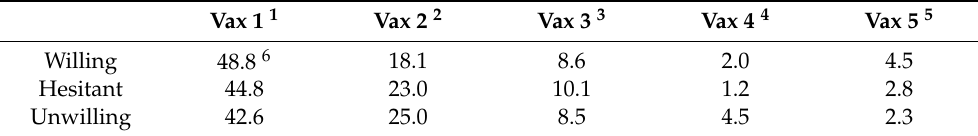
Table 2. Parents’ references for vaccine origins to vaccinate their children aged from 5 to under 12